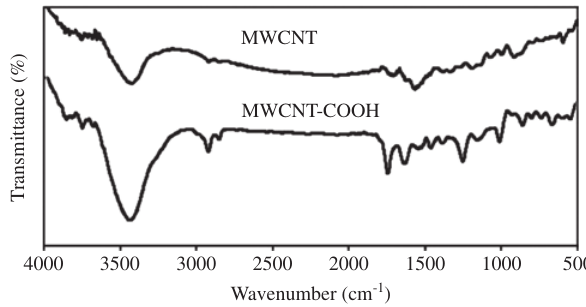
Figure 2: FTIR spectra of pure and functionalized MWCNT.